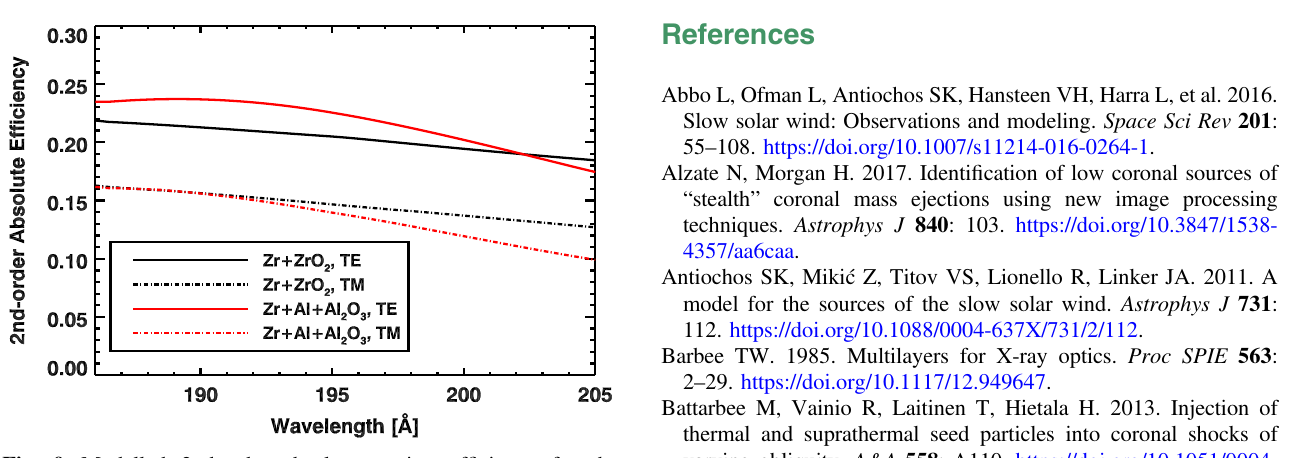
Fig. 9. Modelled 2nd-order absolute grating ef fi ciency for the COSIE blazed re fl ection grating. We calculated ef fi ciencies assuming two coating con fi gurations: 78 Å of Zr with a 10 Å oxidation layer (black), and 88 Å of Zr capped by 201 Å of Al and a 40 Å oxidation layer (red). We also considered two polarization states of the incident beam: transverse electric (TE, solid) and transverse magnetic (TM,